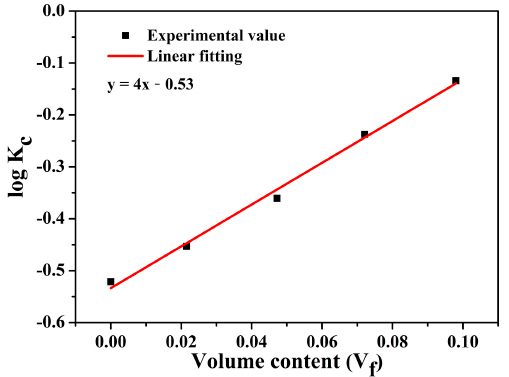
Figure 11. Thermal conductivity of PEN-g-BN hybrids using the Agari model.